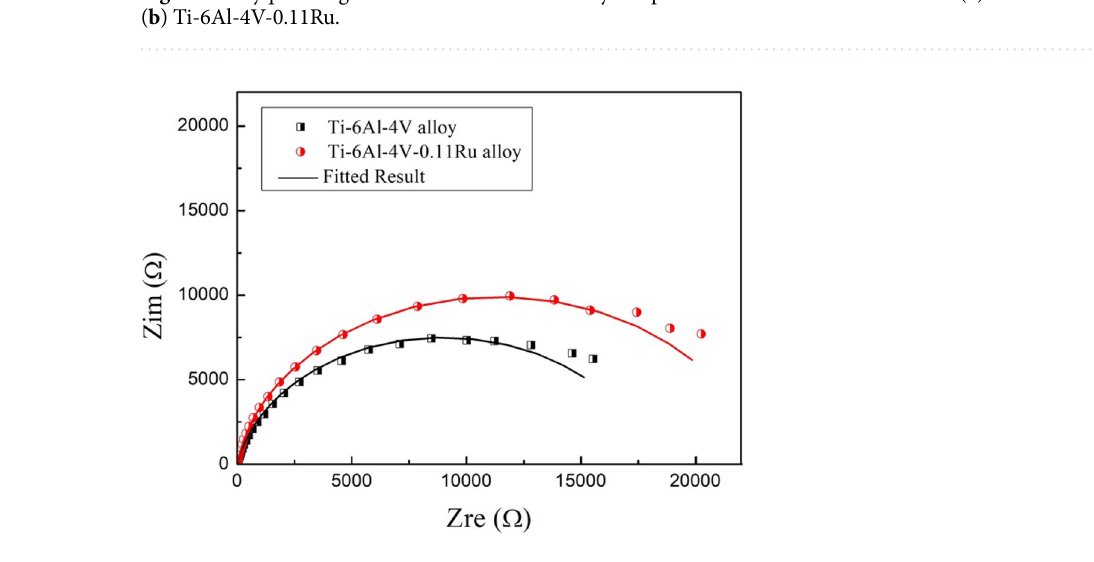
Figure 6. Nyquist diagrams for tested titanium alloy samples under Condition D.